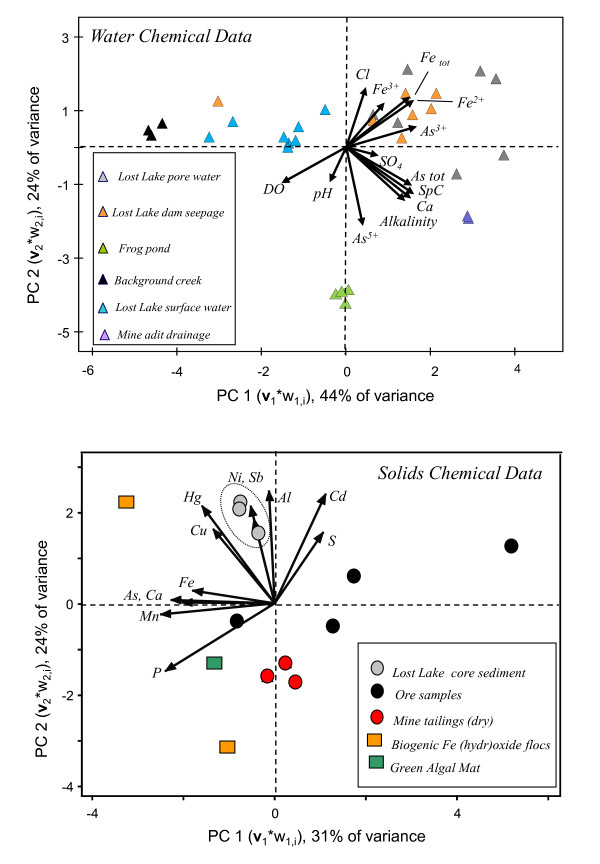
Variance plots generated from principal components analysis (PCA) on selected water (top) and solids (bottom) chemical data collected at sites in the LCMS (see Tables 1 and 2). Solid arrows indicate the direction and importance of each of the chemical parameters to the sample distribution, and amount of parallelism of the arrows indicates the degree to which chemical parameters correlate.